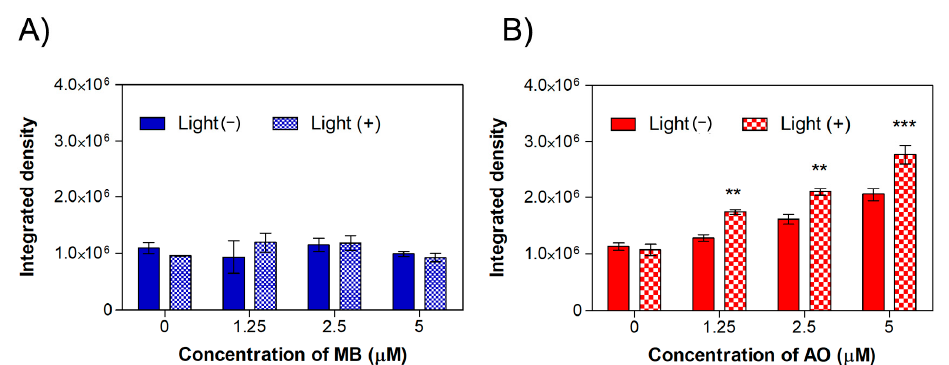
Figure 6. Quantification of fluorescence intensity of MET1 cells treated with ( A ) methylene blue and ( B ) acridine orange either submitted or not to irradiation at 640 nm and 457 nm, respectively. Results are displayed as mean ± standard deviation of the mean ( n = 4), and statistical analysis was performed using a two-way ANOVA with Bonferroni post test, where ** p < 0.01 and *** p < 0.001, with comparison of the fluorescence intensity of irradiated cells with the cells treated with the same concentration and non-irradiated cells.